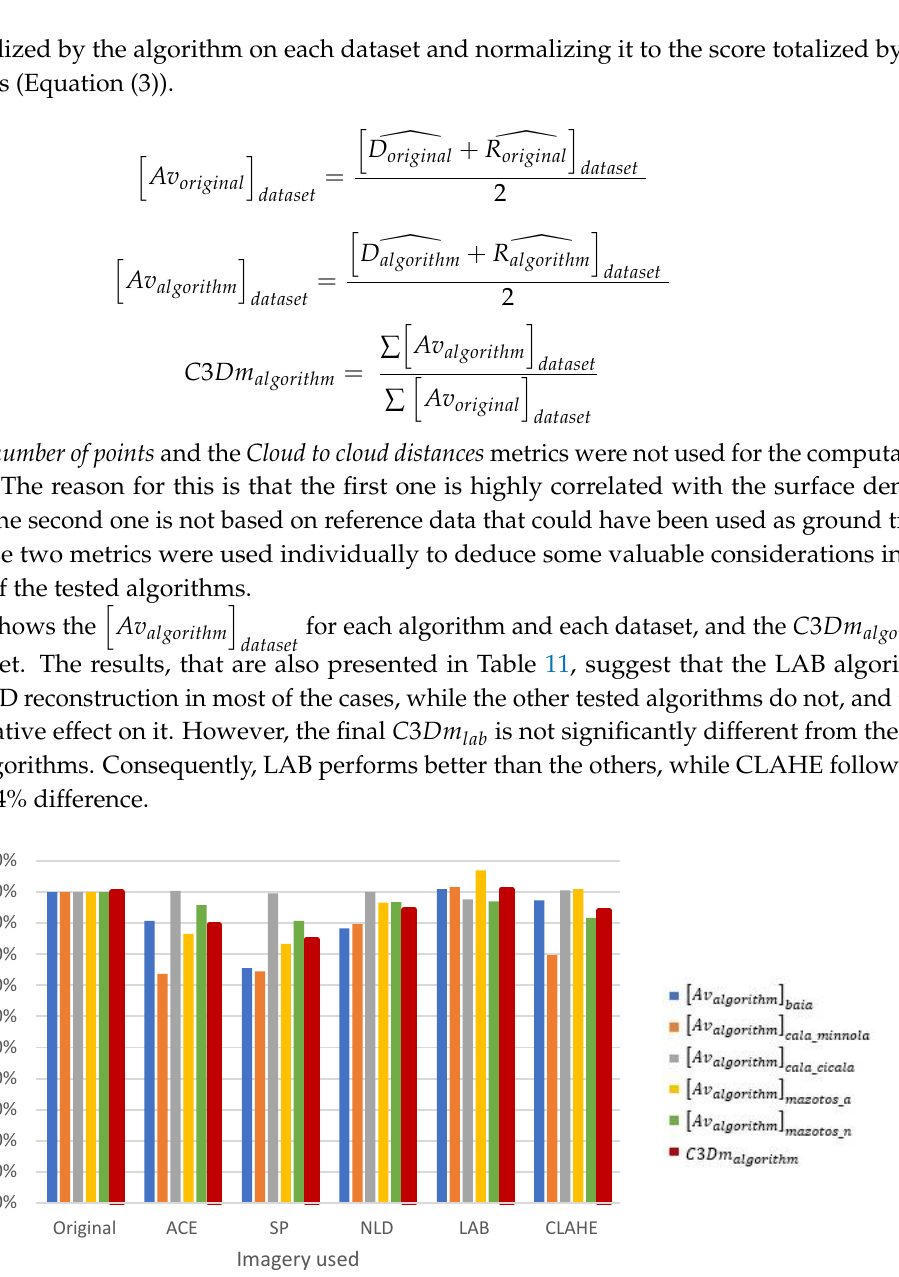
Figure 8. The Combined 3D metric ( C3Dm ), representing an overall evaluation of 3D reconstruction performance of the five tested image enhancing methods on the five datasets.